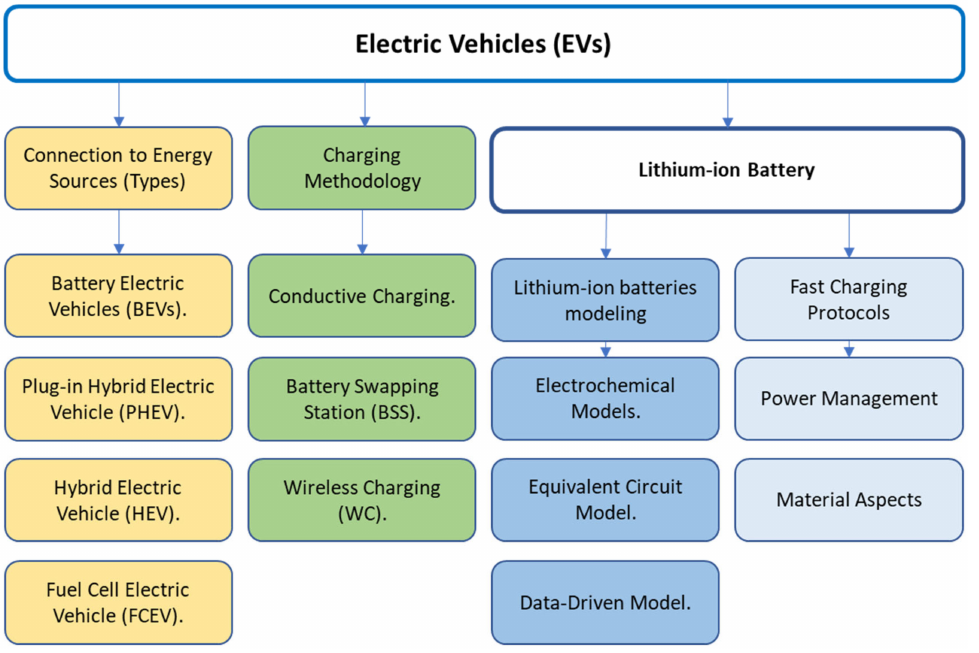
Figure 1. Overview of the electric vehicle (EV) research